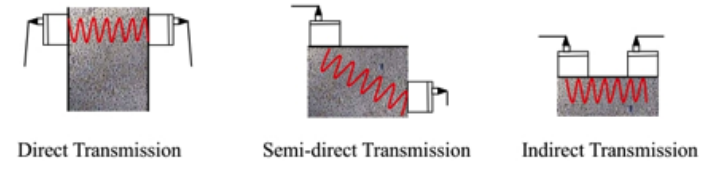
Figure 3. Ultrasonic pulse velocity test methods.